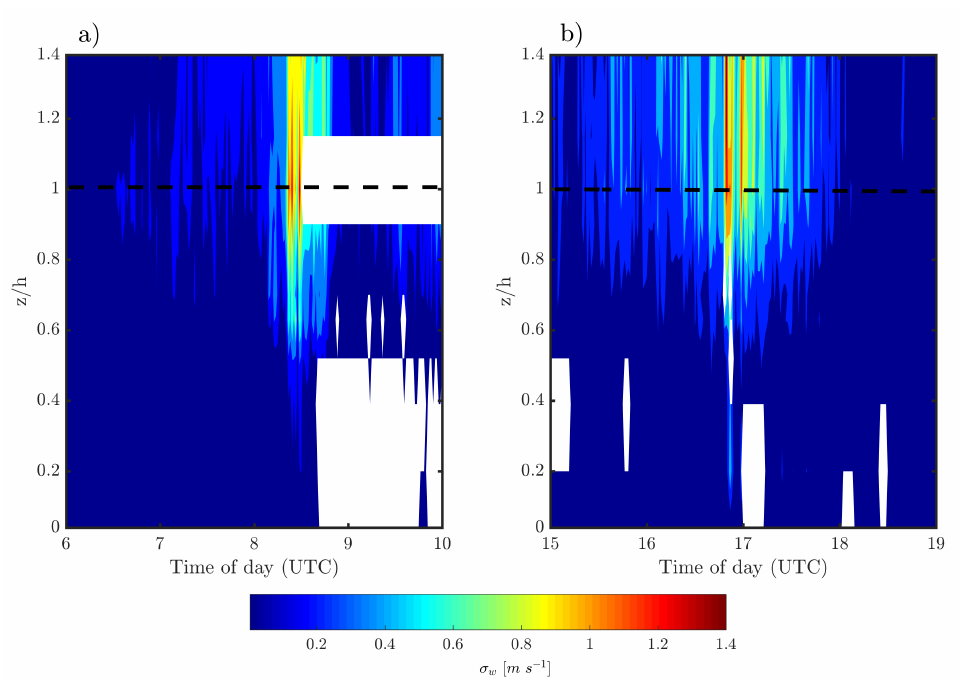
Figure 5. Temporal variation of the vertical profile of σ w [ m s − 1 ] on 21 April 2014 measured at site T0k during: ( a ) the passage of branch 1, and ( b ) of the branch 2 of SL2. The dashed black line corresponds to the top of the canopy. The white rectangle indicates the absence of data.